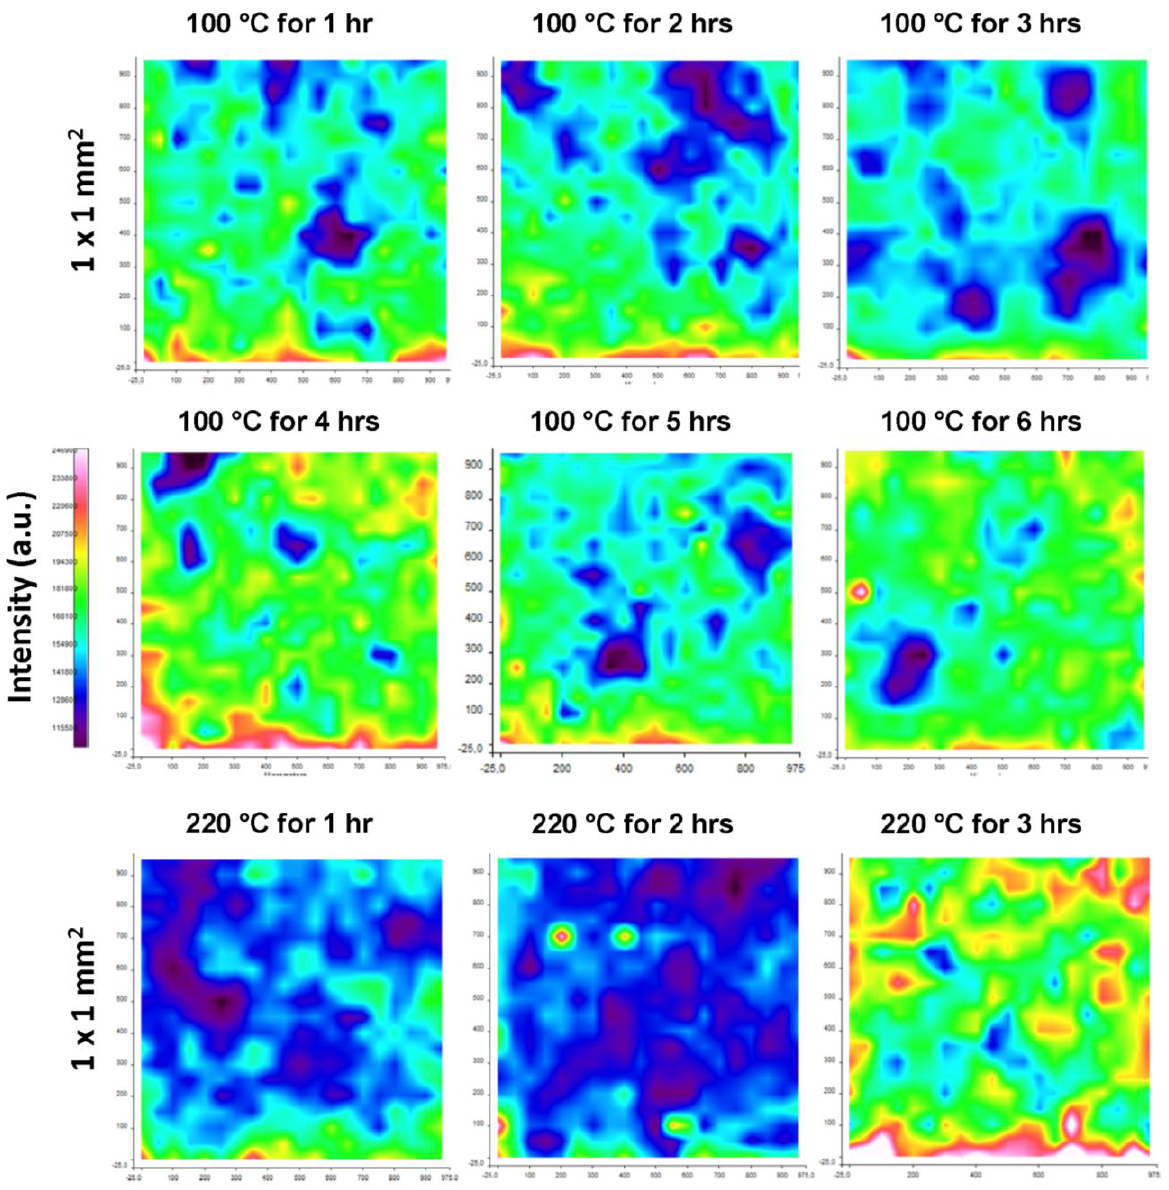
Figure 12. Raman chemical mapping for cured modified MFC films after curing at 100 and 220 °C for different times (X and Y-axis represent distances 0 to 1000 µm). Same intensity scale bar applies to all images, where, red = highest intensity; green = intermediate intensity; blue = lowest